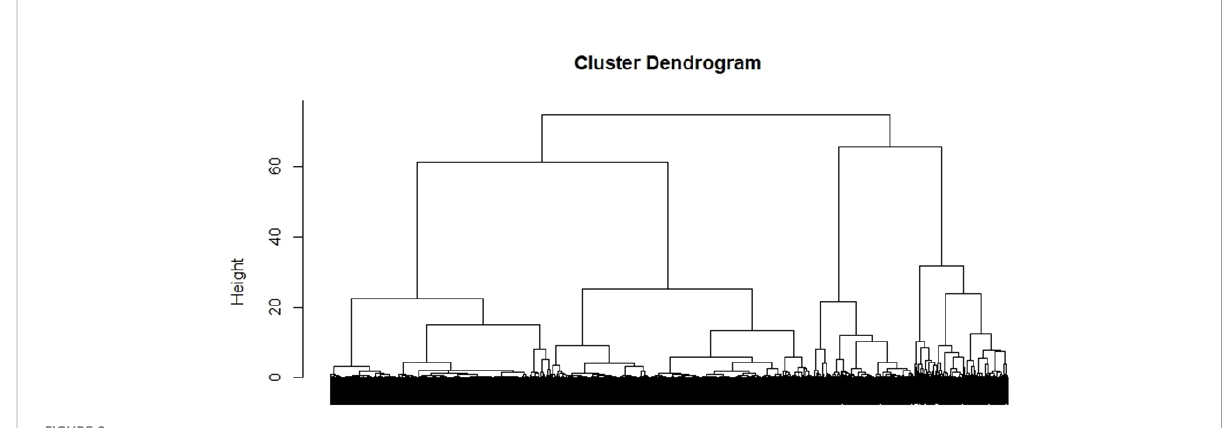
FIGURE 2 Euclidean tree for patient's